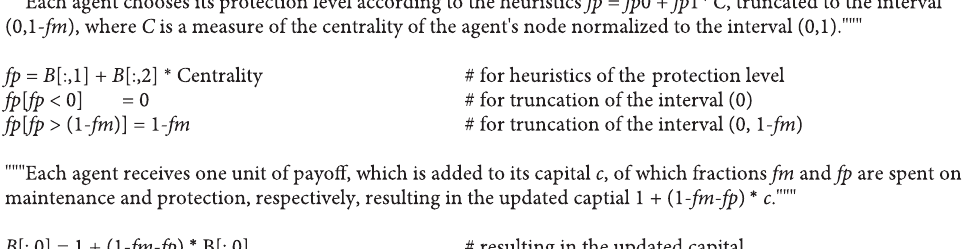
Figure 10: Code book: payoff dynamics.